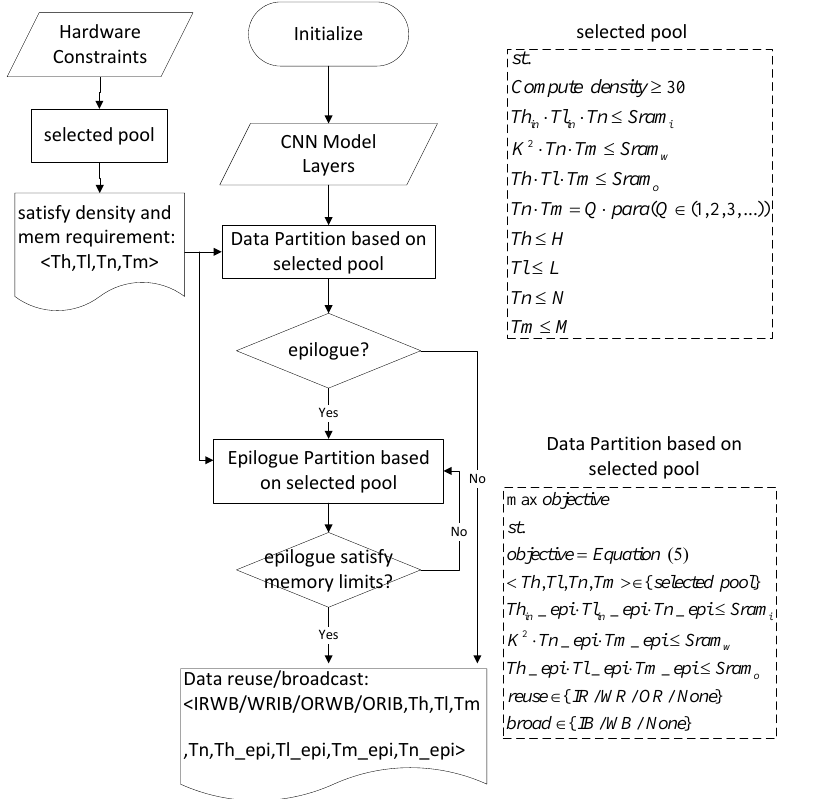
Figure 11. The workflow of the schedule